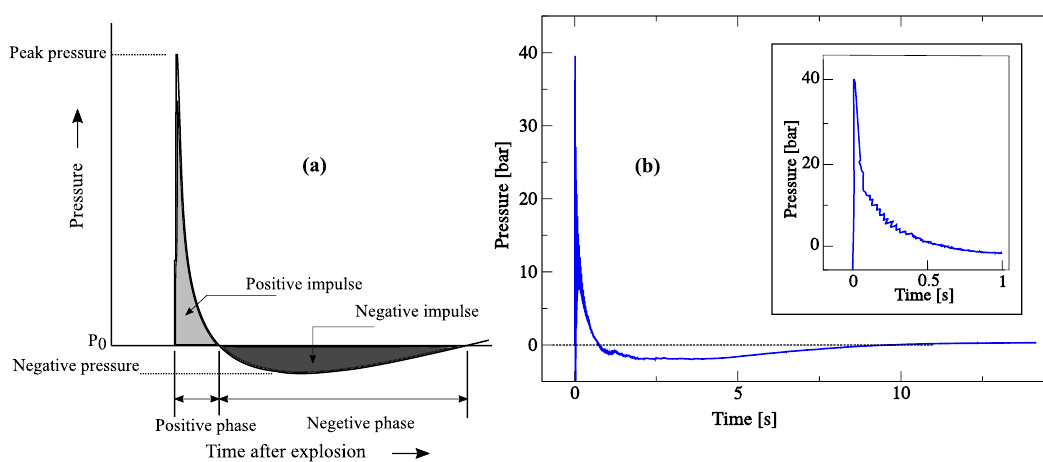
Figure 3. ( a ) A schematic representation of an ideal blast wave pressure profile. ( b ) The actual pressure-time history for a shock wave in the tube. Inset: Enlarge view of the time range between 0 and 1 s.